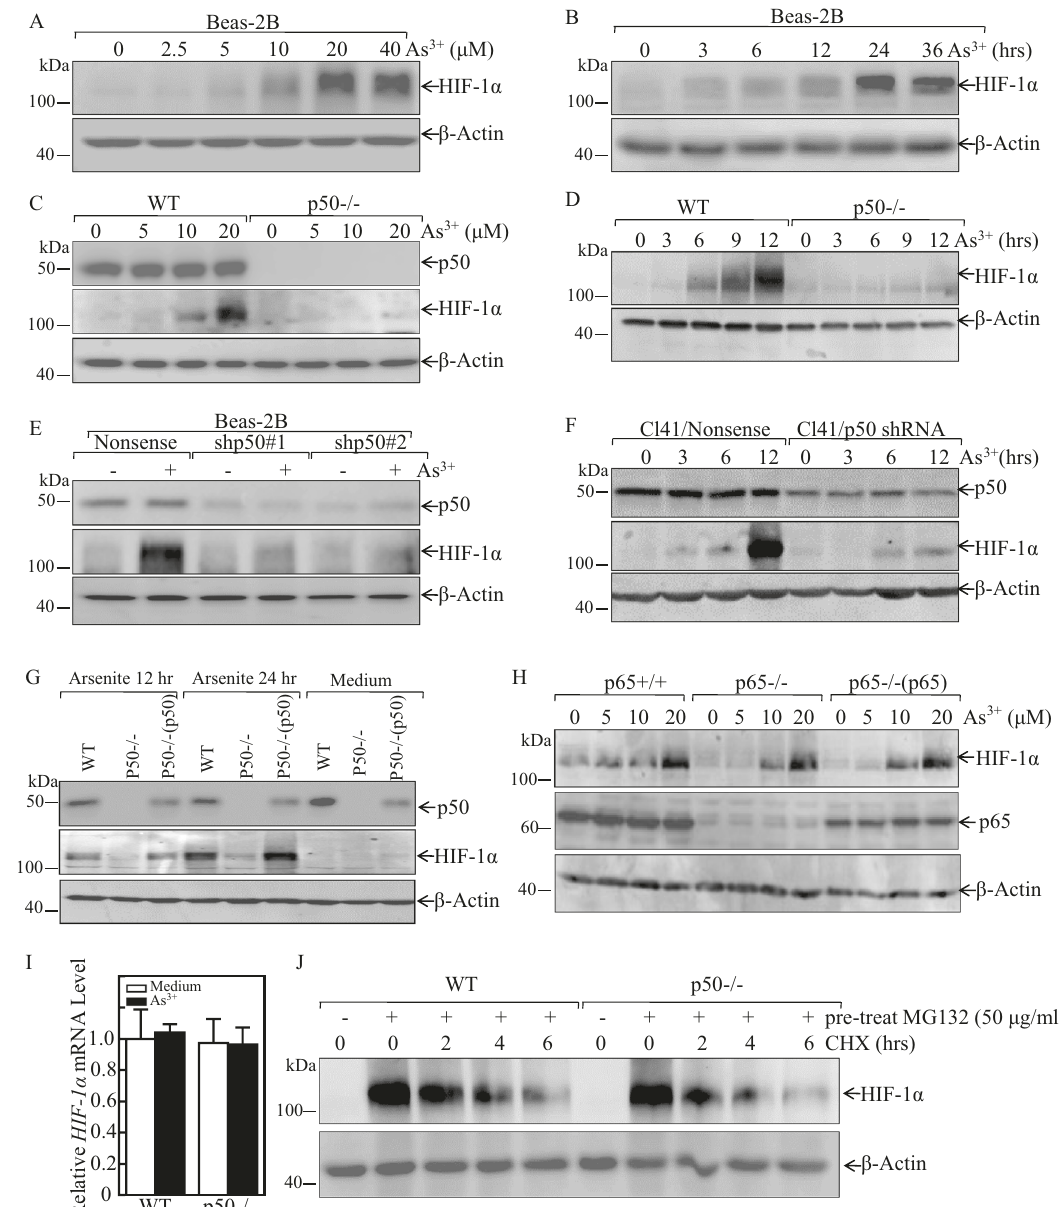
Fig. 1 p50, but not p65, was required for arsenite-induced HIF-1 α protein expression following arsenite treatment. A , B Beas-2B cells were treated with various doses of arsenite for 24 h or 20 μ M arsenite for the indicated time periods. The cells were then extracted and subjected to western blot assay. C , D WT and p50 − / − cells were exposed to indicated concentration arsenite for 24 h ( C ), or were treated with 20 μ M arsenite for the indicated times ( D ). The cells were then extracted and subjected to western blot assay. E , F Beas-2B cells and mouse epidermal Cl41 cells were stably transfected with shRNA p50, these transfectants were then treated with 20 μ M arsenite for 24 h ( E ) or for different time points ( F ) as indicated; The cell extracts were subjected to western blot by using indicated antibodies. G WT, p50 − / − , and p50 − / − (p50) cells were exposed to 20 μ M arsenite for 12 h or 24 h; H p65 + / + , p65 − / − , and p65 − / − (p65) cells were treated with arsenite at indicated doses for 24 h. Whole-cell extracts from each of above experiments were subjected to western blot for the determination of protein expression of p50, p65, and HIF-1 α . β -Actin was used as protein loading control. I WT and p50 − / − cells were exposed to 20 μ M arsenite and the HIF-1 α mRNA expression was determined by Real-Time PCR; J WT and p50 − / − cells were pretreated with 50 μ M of MG132 for 10 h, then these cells were exposed to 50 μ g/ml CHX for the times indicated after removal of MG132, and the cell extracts were subjected to western blot for the determination of protein expression of HIF-1 α . β -Actin was used as protein loading control. sites in ATG7 promoter sequence (Fig. 4C). We further compared the ATG7 mRNA and ATG7 promoter transcription activity were those transcription factors expression in Beas-2B(nonsense) and enhanced in Beas-2B(shp50) as compared to those in Beas- Beas-2B(shp50) cells. The results indicated that p50 knockdown 2B(nonsense) cells following arsenite treatment (Fig. 4A, B), promoted Sp1 expression following arsenite exposure, while it conclusively demonstrating that p50 regulating ATG7 expression had no effect on the other transcription factors expression, at transcription level. Using TRANSFAC 8.3 in PROMO HOME PAGE including Elk, Stat5, and Ets (Fig. 4D). These results suggested that database, we analyzed the potential transcription factor binding